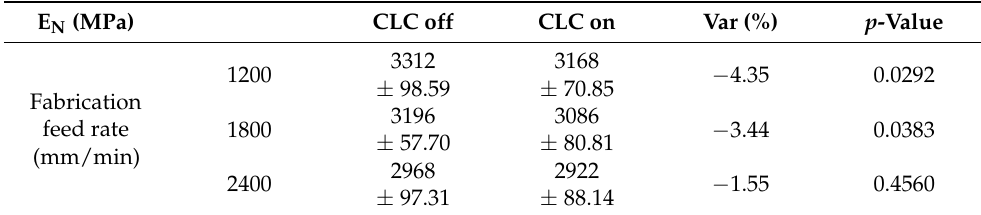
Table 8. Young’s modulus E N .